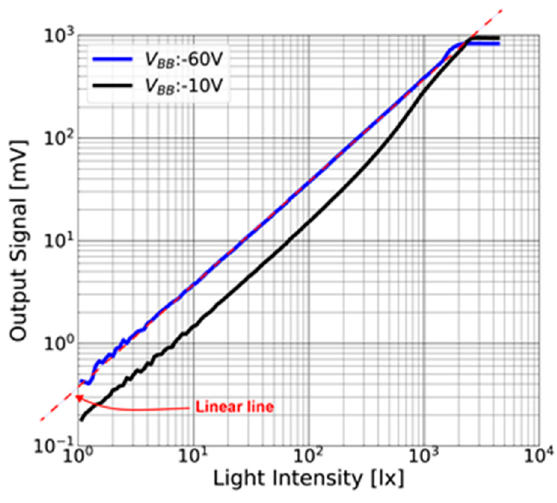
Figure 13. Linearity of the pixel output to light intensity.